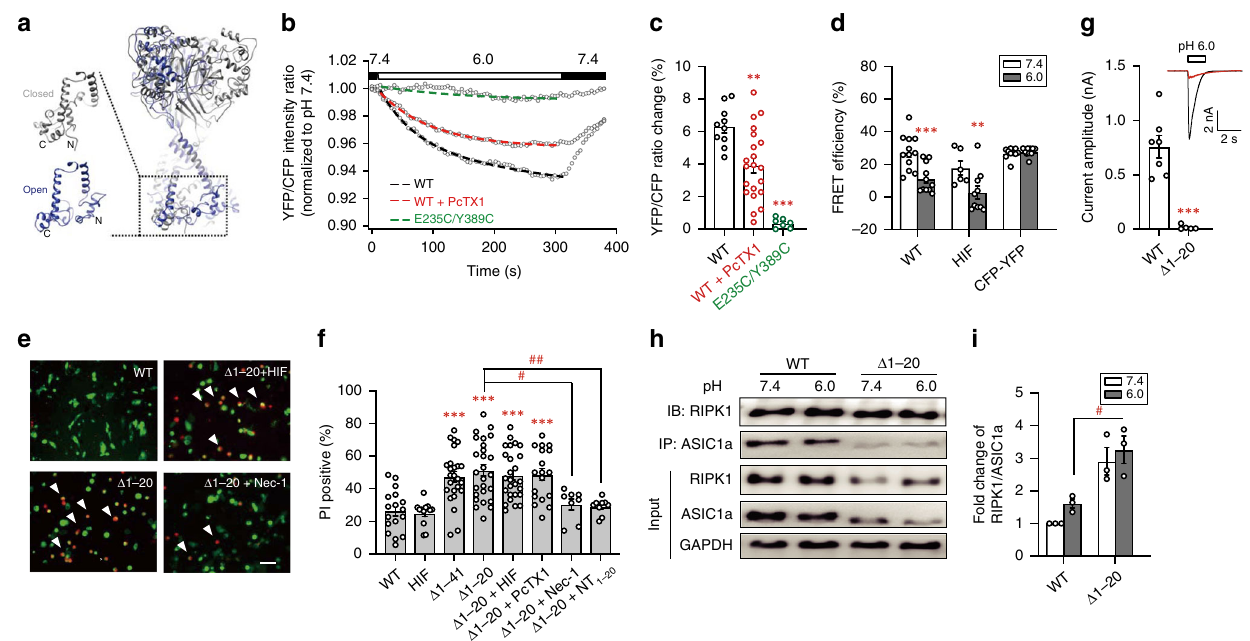
Fig. 2 Distal N-terminal region of ASIC1a is crucial for inhibiting CP-1 death motif. a De novo Rosetta modeling of full-length ASIC1a. Gray color represents closed state base on PDB structure 5wku, while blue color depicts open state based on PDB structure 4ntw. b Acidosis-induced dissociation of ASIC1a-CT from its NT, as measured by FRET: YFP/CFP emission ratio (F 525 /F 482 ) with excitation at 405 nm. CHO cells expressing CFP-ASIC1a-YFP (WT) or CFP-ASIC1a-E235C/Y389C-YFP (E235C/Y389C) were untreated or treated with PcTX1 (100 nM). Bath solution pH changed from 7.4 to 6.0 as indicated. Data points are averages of n = 10-21 cells. Dashed lines are fi ts by exponential function. c Summary of % ratio changes at 5 min of pH 6.0 treatment for data in ( b ). ** p < 0.01, *** p < 0.001 vs. WT, by ANOVA. d Spectra FRET for energy transfer between CFP and YFP of WT, CFP-ASIC1a-HIF- YFP (HIF), and CFP-YFP at pH 7.4 and 6.0. n = 6 – 12, ** p < 0.01, *** p < 0.001 vs . corresponding pH 7.4, by ANOVA. e , f Representative images ( e ) and summary ( f ) of PI staining of CHO cells transfected with WT ASIC1a and its HIF and NT truncation mutants at pH 7.4. Scale bar, 20 µ m. Nec-1 (20 µ M),